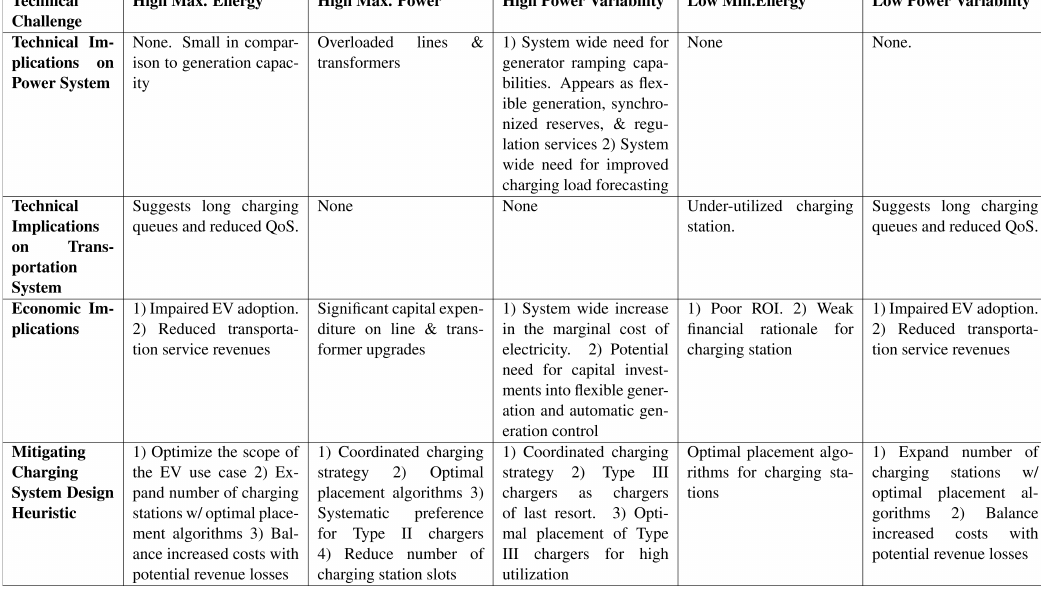
Figure 16. Charging System Design Heuristics for Mitigation of Impacts to Transportation-Energy Nexus